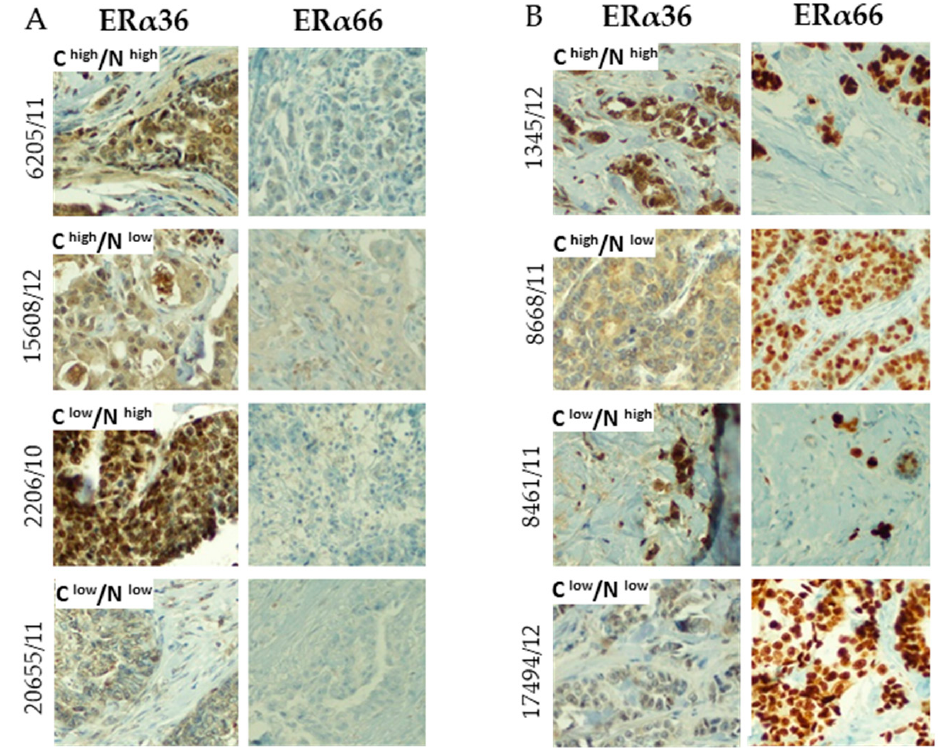
Figure 6. Exemplary photos of immunohistochemical staining of breast cancer samples with different ER α 66 status (panel A – negative, panel B – positive according to Allred score) and ER α 36 status. The ERa36 staining pattern has additionally been divided into positive and negative in cytoplasmic ( C ) and nuclear (N) localization based on the immunohistochemical score of the samples. All photos were taken under 20× magnification.